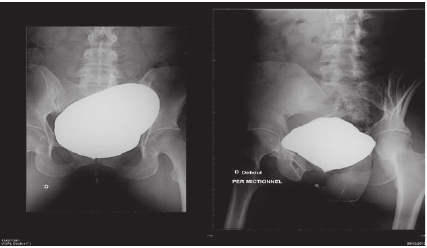
Figure 2: Retrograde cystography showing the vesical